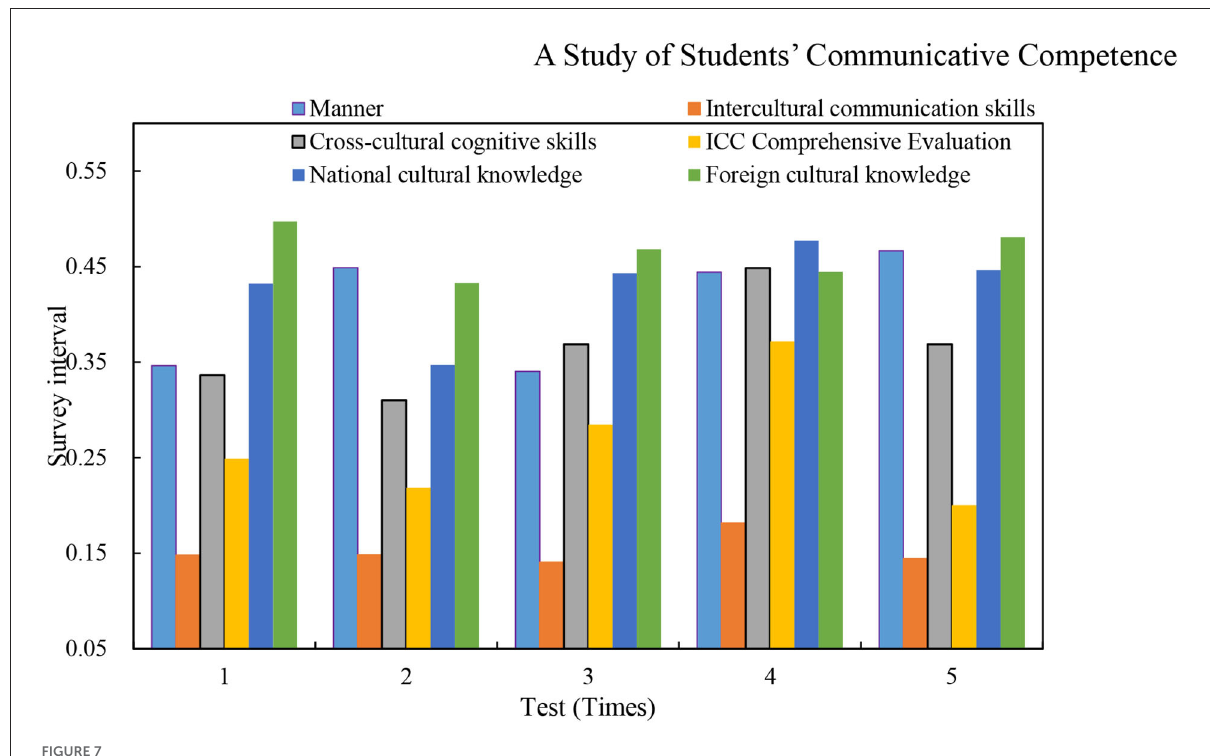
FIGURE7 Evaluation of students with grades below